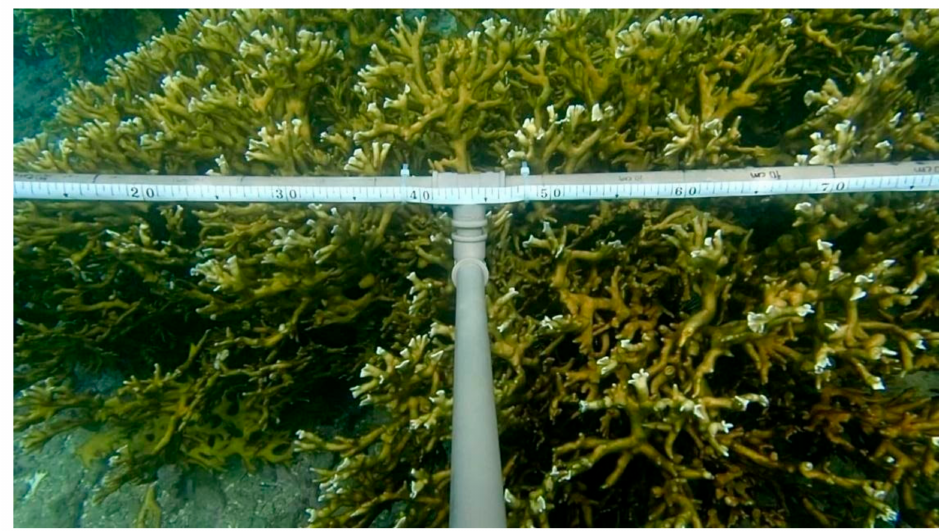
Figure 3. Polyvinyl chloride (PVC) apparatus (handle and frame with metric tape) used in the field study to obtain presence records and measurements of Millepora alcicornis